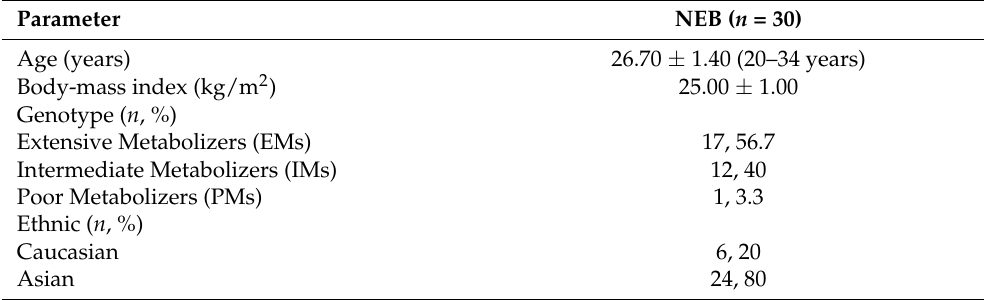
Table 3. Demographic characteristics (mean ± standard deviation) of patients from literature